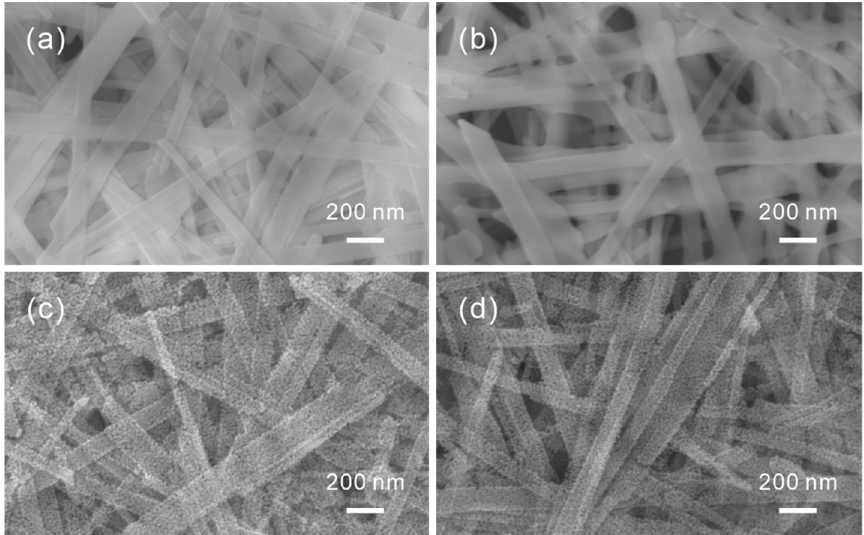
Figure 1. SEM images of ZnSe·0.5N 2 H 4 precursor nanobelts before ( a ) and after ( c ) thermal oxidation, and 0.61 at% Pb-exchanged ZnSe·0.5N 2 H 4 nanobelts before ( b ) and after ( d ) thermal oxidation.